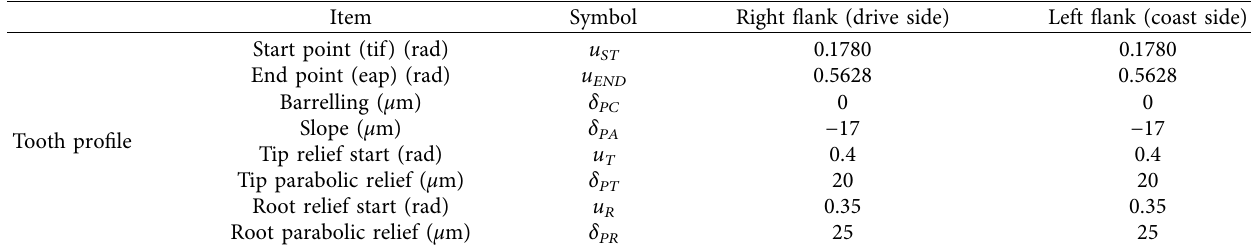
Figure 7: LTCA of theory and modification tooth surface under misalignment ( △Σ � 0.313mrad, △ E � − 0.06mm, △ Xp � 0.162mm, and △ Xw �− 0.19mm) in the work environment. (a) Theory design. (b) Modification Table 2: Micromodification parameters of helical gear.